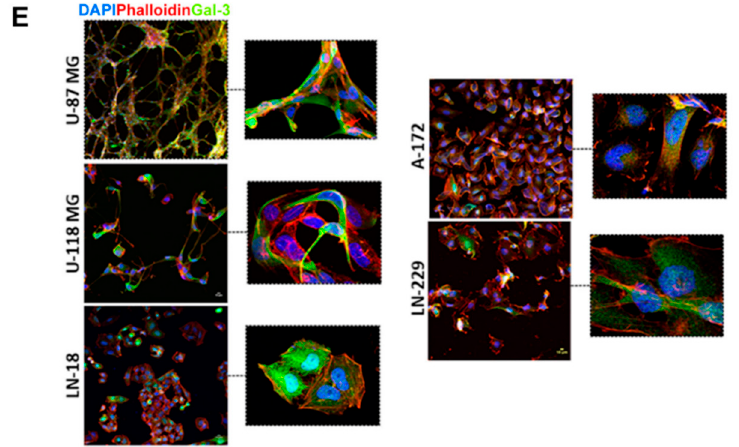
Figure 2. Galectin-3 expression and microglia in an SVZ cancer model and in cancer cells. ( A ) Gal-3 expression (red) and microglial Iba1 expression (green) are increased in the SVZ of the IDH1 R132H model of gliomagenesis as described in Bardella et al., 2016. Scale bar is 5 microns. ( B ) Quantification of A showing significantly increased Gal-3 in the glioma model SVZ. ( C ) Typical Iba1+ microglial morphologies in the SVZ ranging from intermediate to activated. ( D ) Quantification of C showing that in the IDH1 model there are significantly more active microglia in the SVZ. ( E ) Gal-3 expression (green) is found in five glioblastoma cell lines. Phalloidin (red) used to detect actin. (( A – E ): Szele, Tomlinson, Bardella and O’Neil labs, unpublished data). * p < 0.05, ** p < 0.01.